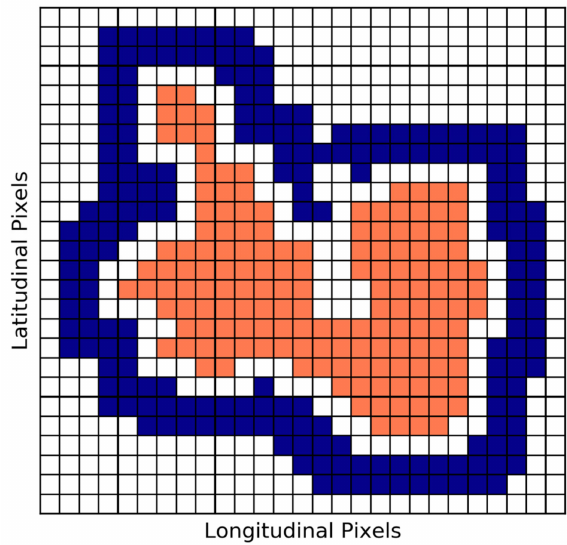
Figure 1. Schematic illustrating the outcome of the reference bu ff er procedure. Each square represents a single 500 m 2 MODIS pixel. Orange pixels indicate the location of a continuous fire object. Blue pixels indicate the reference bu ff er. A 1-pixel bu ff er is omitted to reduce edge e ff ects. The width of the blue bu ff er is chosen such that the number of bu ff er pixels is approximately equal to the number of pixels in the fire